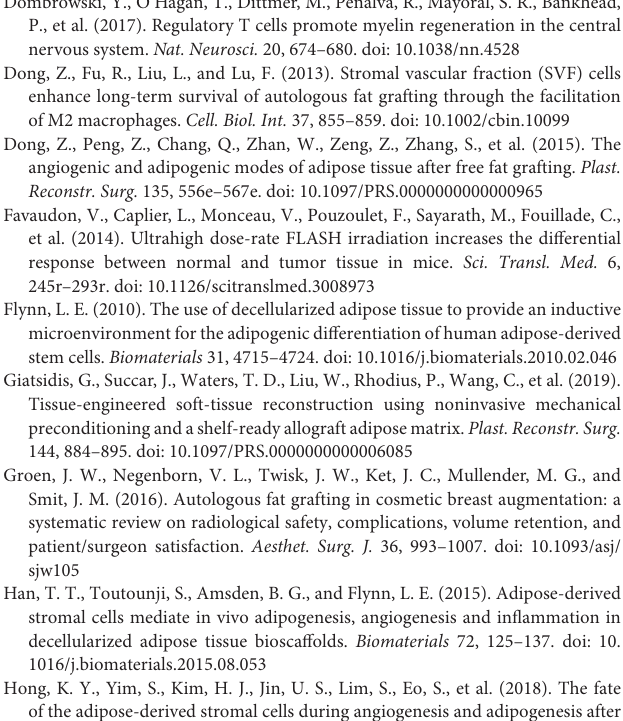
Supplementary Figure 1 | Masson’s trichrome staining of Aff, Df, and Rdf grafts. (A) On day 90, thick fibrous tissue was observed in Df and Rdf grafts. By contrast, Aff grafts showed reduced collagen accumulation and normal adipose tissue structure. (B) Quantification of fibrosis areas in the grafts, showing that the